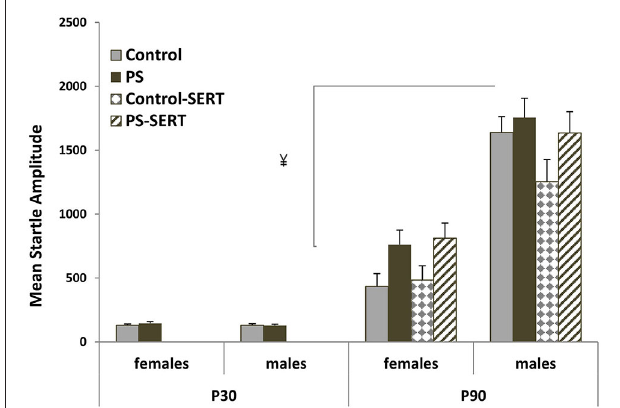
FIGURE 2 | ASR amplitude (in arbitrary units) at P30 and P90 performed in the animals of both sexes subjected or not to prenatal stress (PS and CONTROL), vs. subjected or not to prenatal stress and treated with SERT (Control-SERT and PS-SERT) (5 mg/kg/day) . Mean values ± standard error (at P30, n = 18–20 animals per group and sex; at P90, n = 9–11 per group and sex). (cid:85) , p < 0.05 indicates a main effect of sex in all experimental groups.